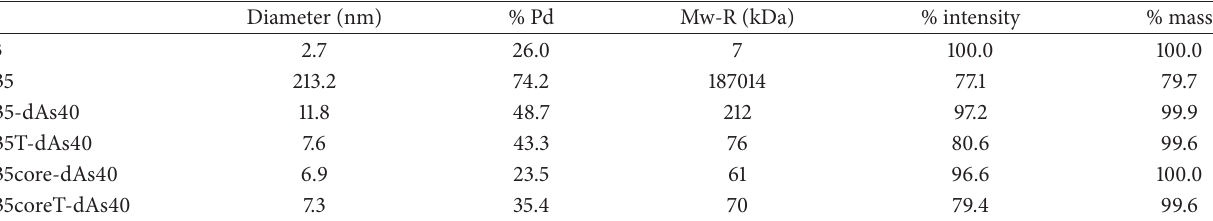
Table 2: DLS measurement of each ODN in Figure